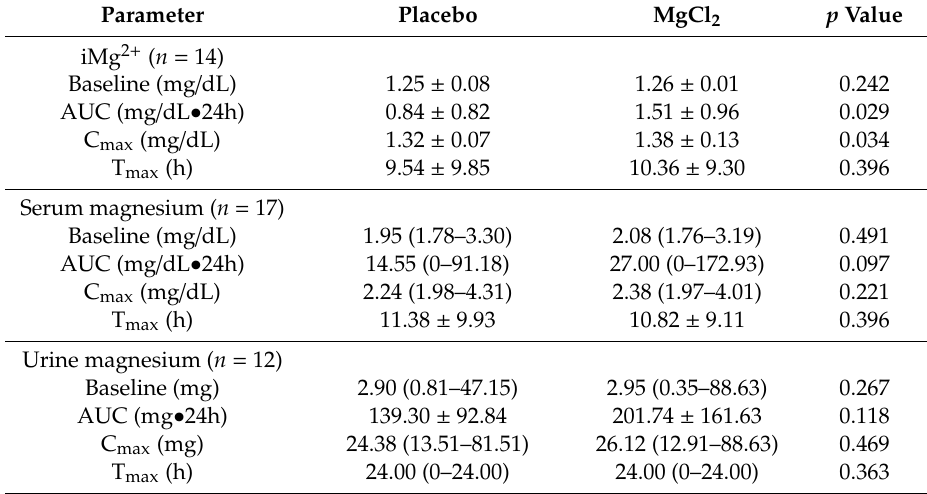
Table 2. Absorption kinetics for whole blood iMg 2 + and serum total magnesium concentrations and urinary magnesium